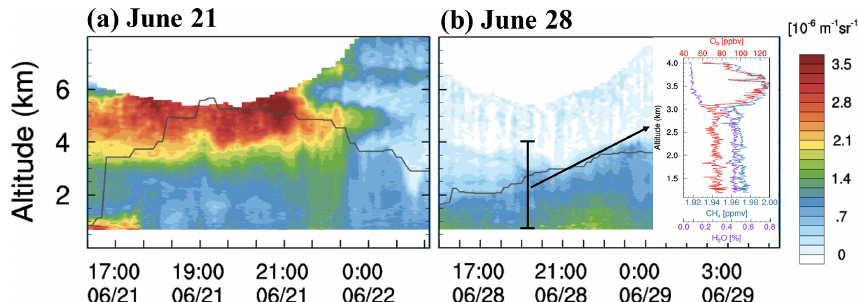
Figure 10. Time–height curtain plots of the TOPAZ aerosol backscatter above the North Las Vegas Airport during 21–22 June (a) and 28 June 2017 (b) . Data are shown at UTC time. The inset graph in (b) shows vertical profiles of water vapor (purple), CH 4 (blue), and O 3 (red) measured by the Scientific Aviation flight above the Las Vegas Valley during 19:15–19:35 28 June (UTC) (flight track in Fig. 1).